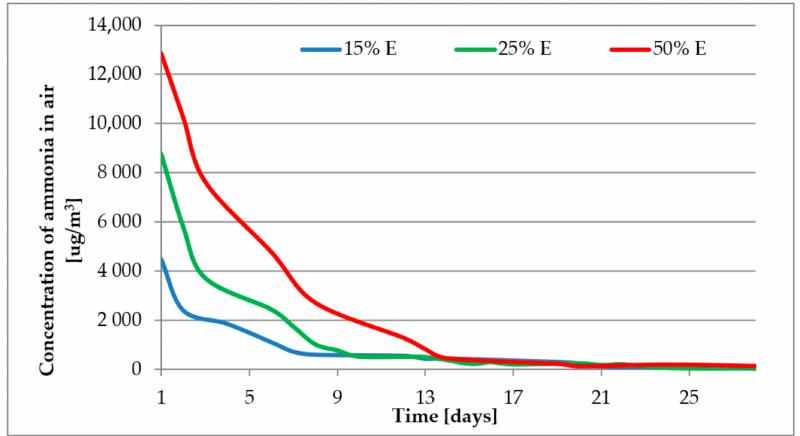
Figure 10. Emission of ammonia from mortars—sample